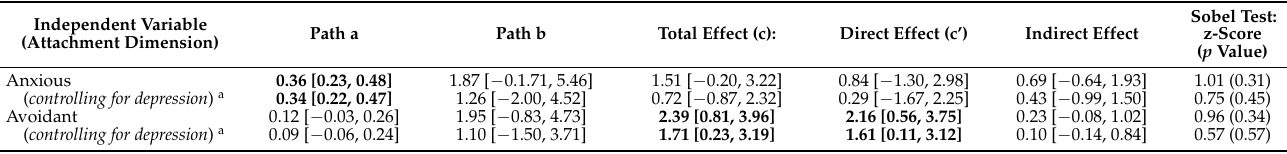
Table 4. Mediation of attachment security effects on suicidal ideation via hypomentalising, controlling for age and gender. Independent Variable (Attachment